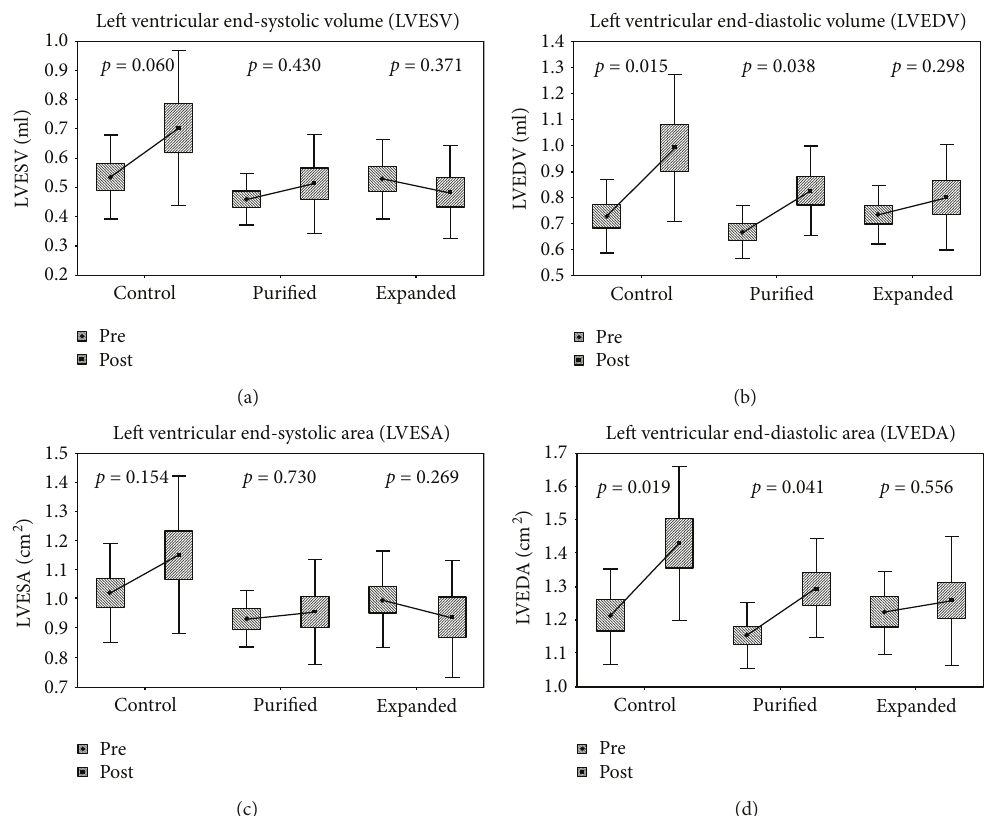
Figure 2: Echocardiographic evaluations revealed better-preserved hearts in the group of animals transplanted with expanded CD133 + cells. Comparison of left ventricular end-systolic volume (a), left ventricular end-diastolic volume (b), left ventricular end-systolic area (c), and left ventricular end-diastolic (d) within each group pretreatment and posttreatment. The results are presented as the mean (point in the box) with the standard error (stripped boxes) and standard deviation (lines). Control =control group, injected with isotonic saline solution (sodium chloride 0.9%). Puri fi ed=transplanted with puri fi ed CD133 + cells. Expanded =transplanted with expanded CD133 + cells. The p values of each comparison are shown on top of the